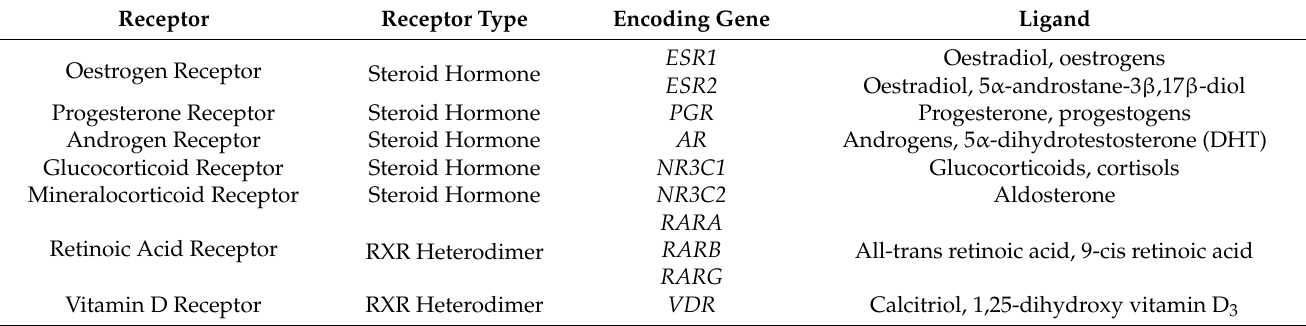
Table 1. Main nuclear receptors involved in breast cancer and their natural